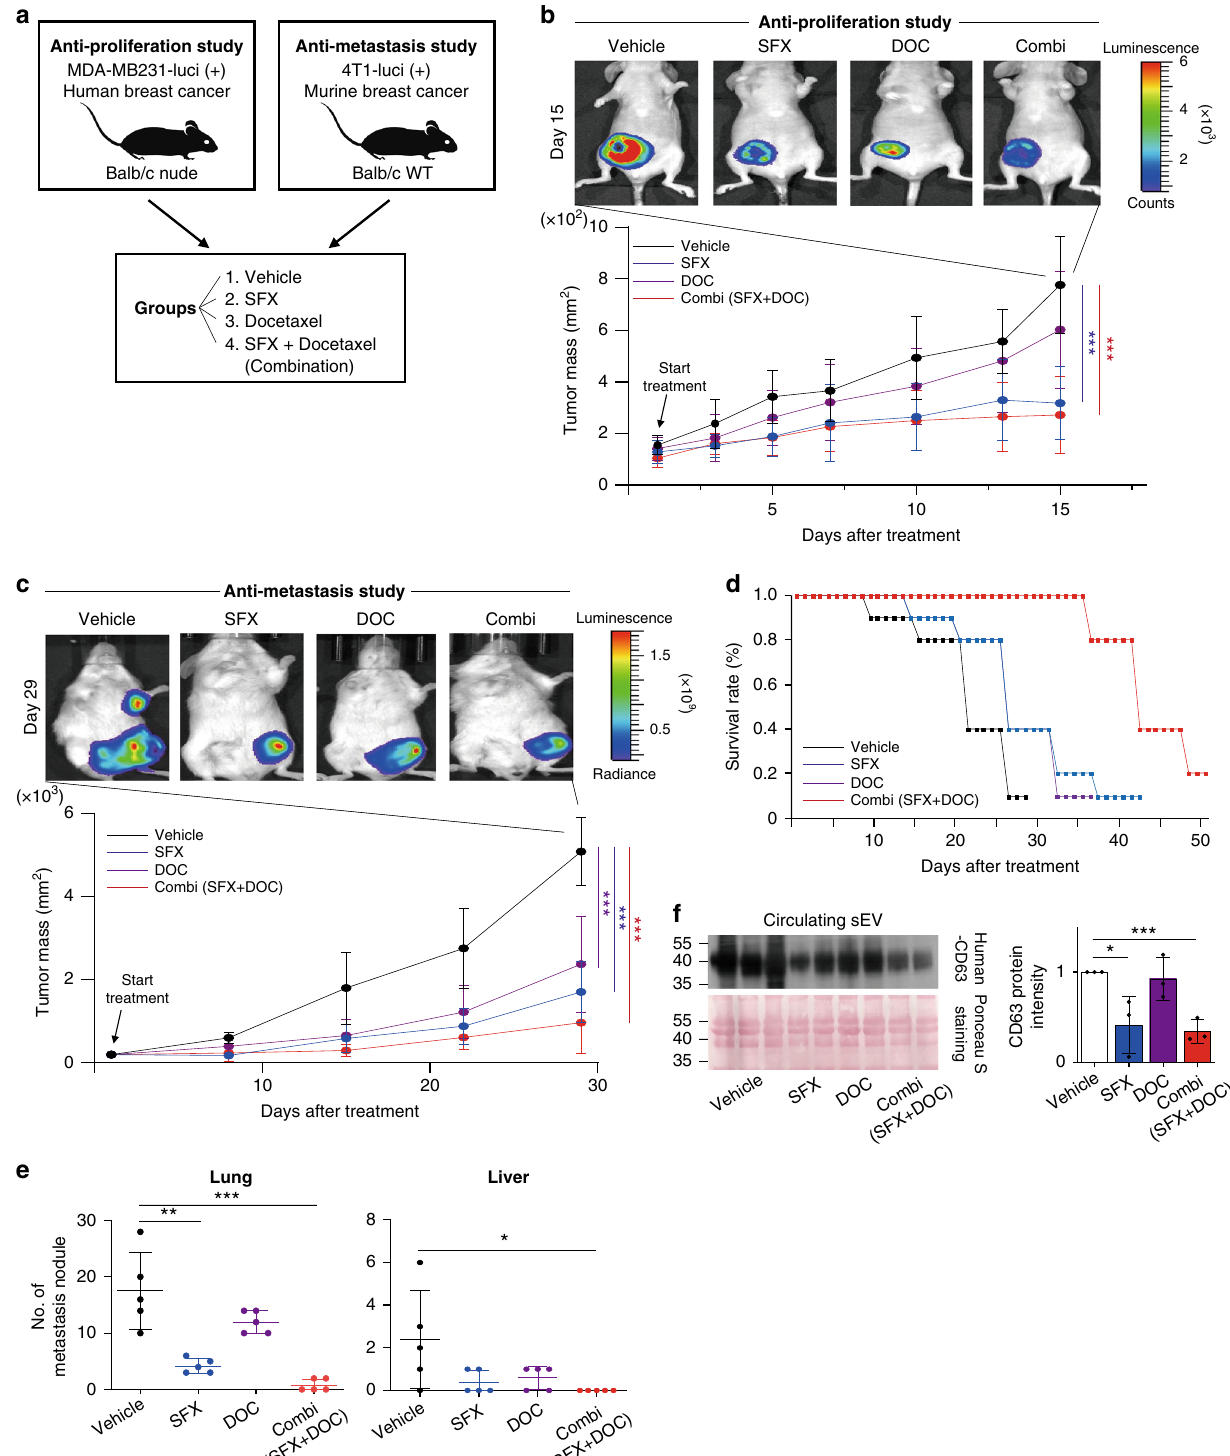
metastasis of mouse 4T1 breast cancer xenografts on day 29 relative to the vehicle group (Fig. 2c), thus survival rates were signi fi cantly increased (Fig. 2d). In addition, SFX treatment markedly reduced the countable colonies of metastatic foci of 4T1 cancer cells in the lung and liver (Fig. 2e) with massive growth of tumor nodules of the experimental mice, compared with those of control animals. To further study whether SFX can inhibit the secretion of sEV from transplanted cancer cells in vivo, we